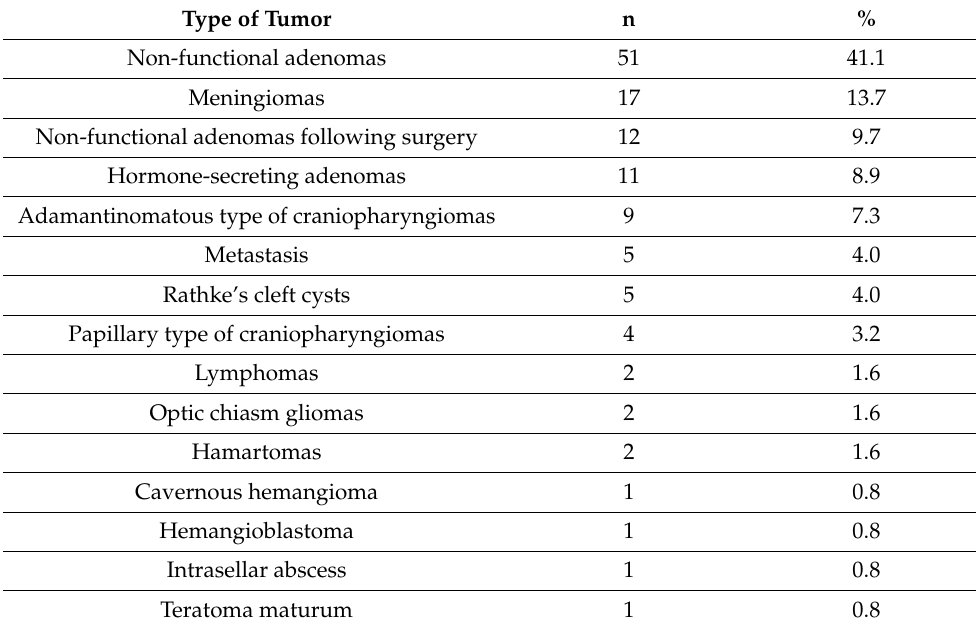
Table 1. Division into groups by type of